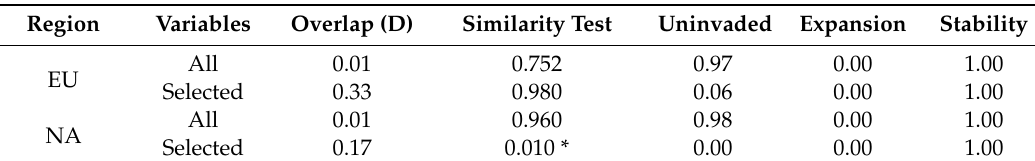
Table 3. Summary of p values for the niche test of Asian long-horned beetle between native range in Asia and invasive range in Europe (EU) and North America (NA) using all and the selected climatic variables. Significant p values ( α = 0.05) are represented by *.